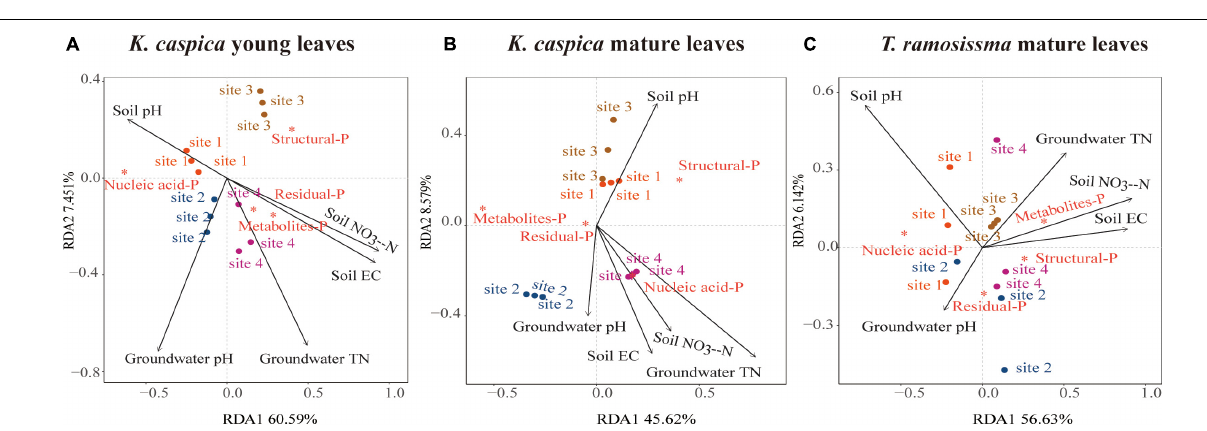
FIGURE 5 | Coefficient of variation of among foliar-P fractions content at the four study sites.